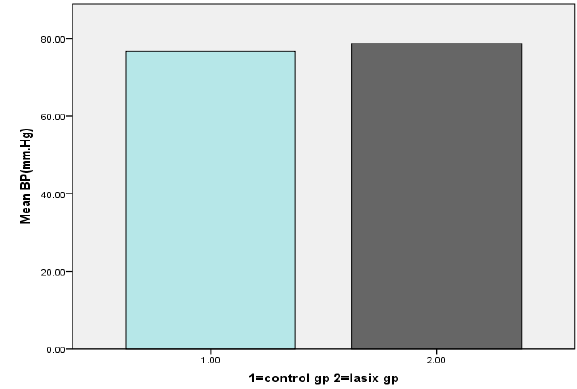
Figure (7): shocked patients received normal saline versus shocked patient received Furosemide in sense of serum creatinine, there is significant statistical difference (p=0.001).